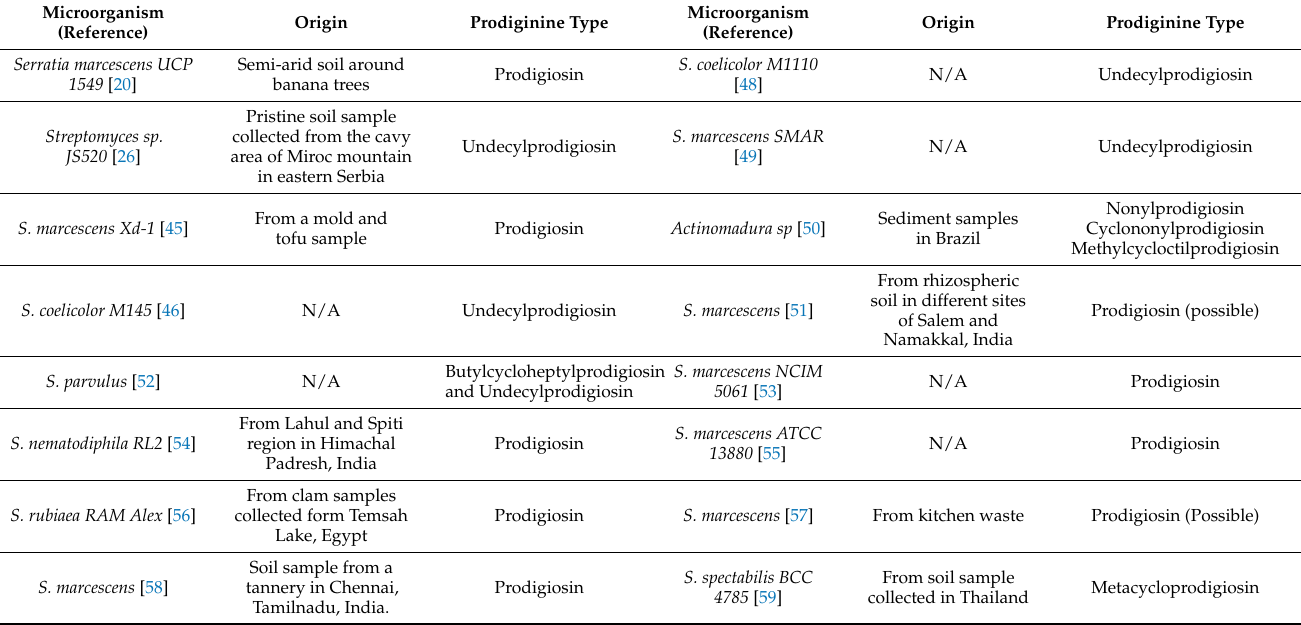
Table 1. Prodigiosin producing bacteria reported in